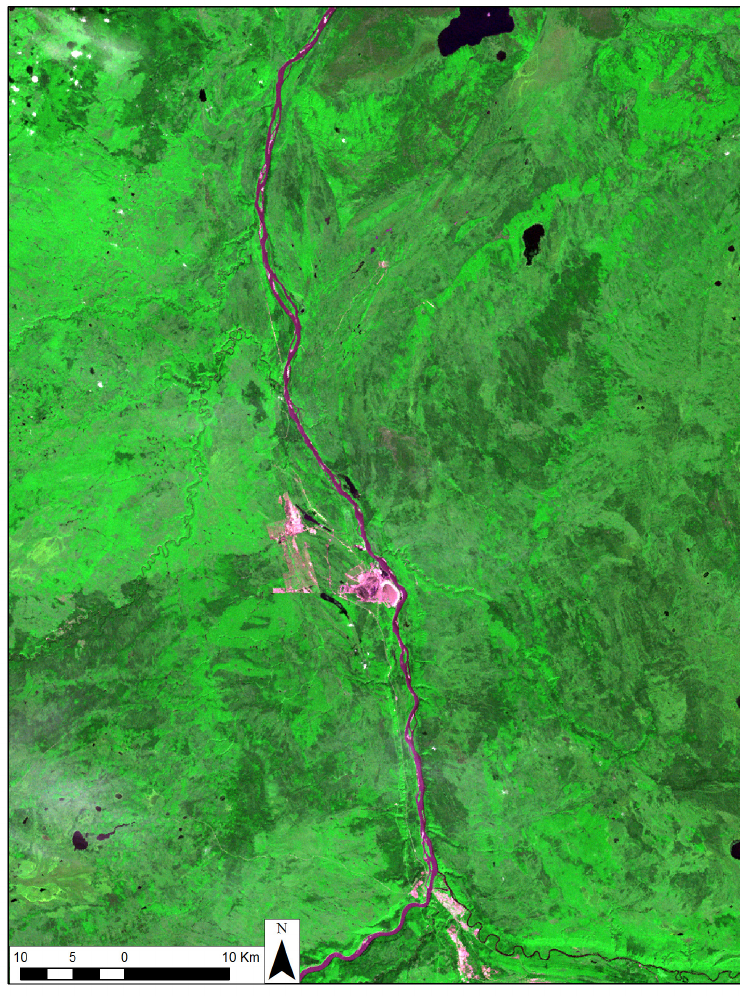
Figure 1. The Athabasca Oil Sands area north of Fort McMurray in 1974. The Suncor mine and plant hugs the bank of the Athabasca River; the site of the Syncrude project is west of Suncor. Map: © P.